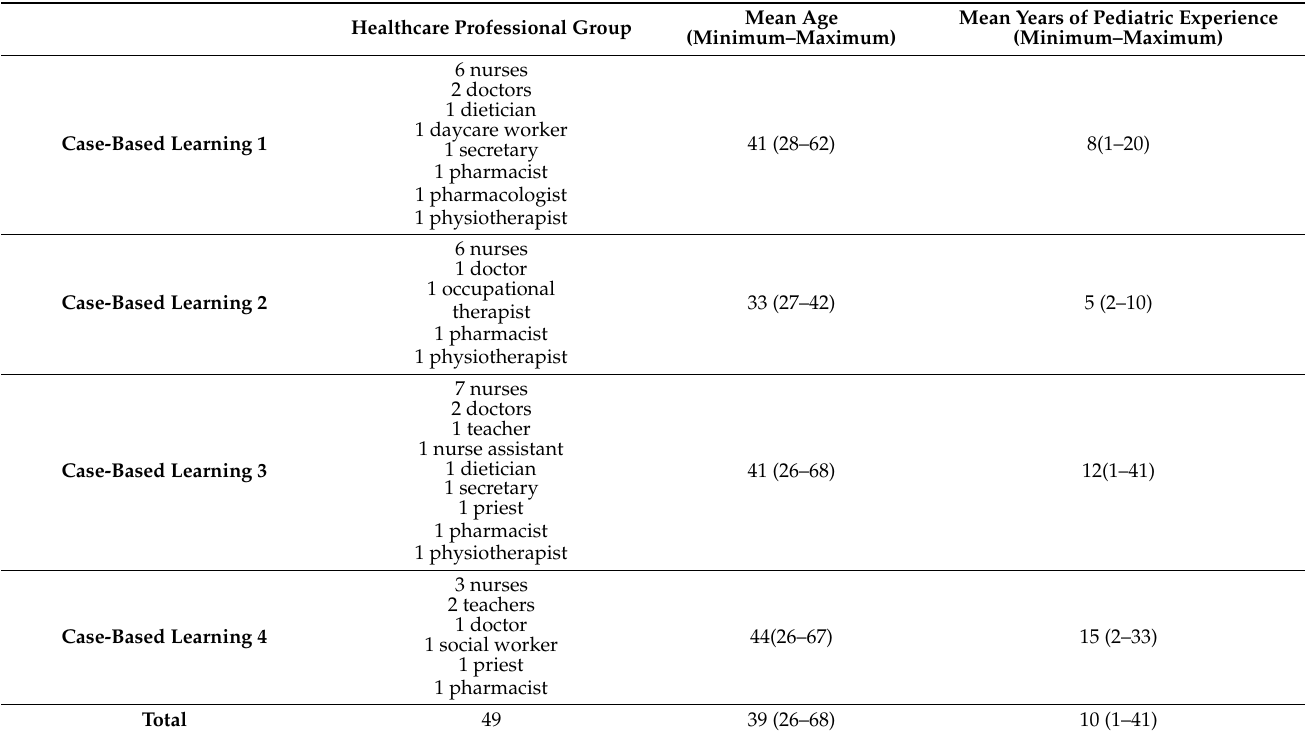
Table 2. Demographic data of healthcare professional groups, mean age, and mean years of paediatric experience. Mean Age Mean Years of Pediatric Experience Healthcare Professional Group (Minimum–Maximum)